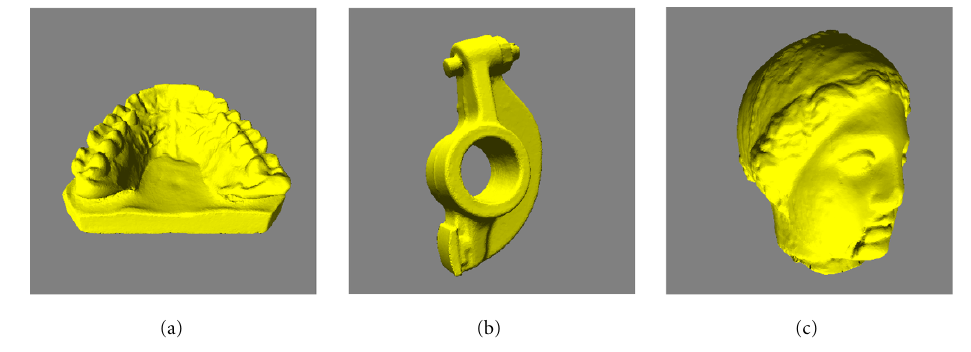
Figure 7: 3D reference models. (a) Teeth model with 69 , 451 triangles. (b) Rocker Arm model with 116 , 602 triangles. (c) Venus model with 134 , 342 triangles.